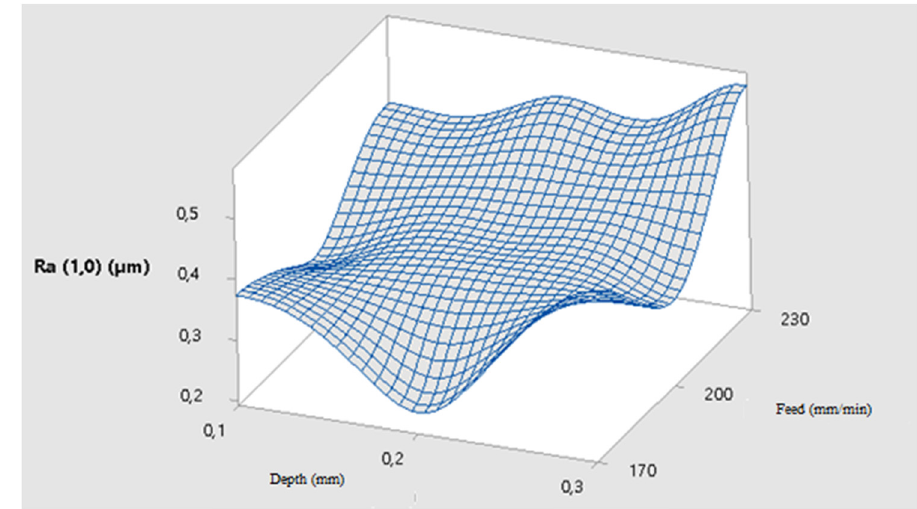
Figure 9: E ff ects of the depth of cut and feed rate on surface roughness.